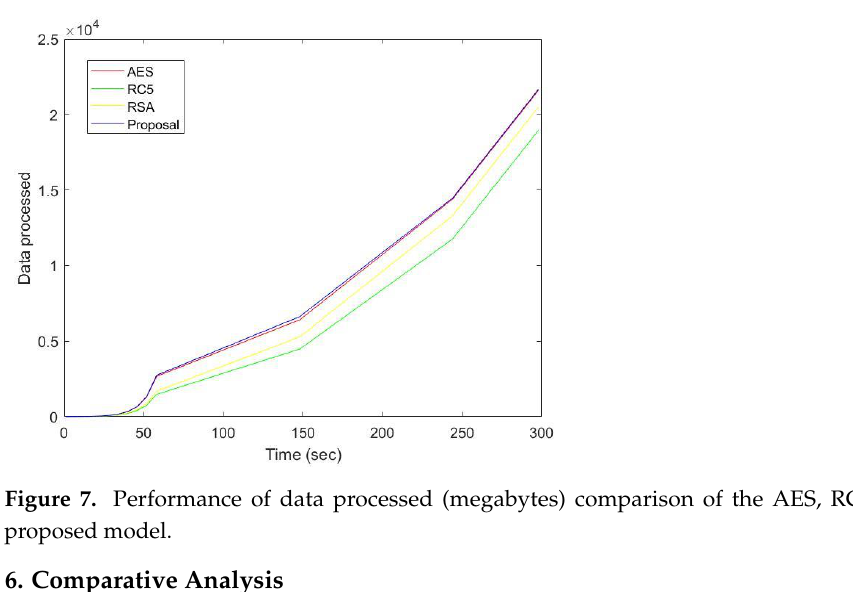
Figure 6. Performance of data processed (megabytes) comparison of the AES, RC5, RSA, and pro- posed model.